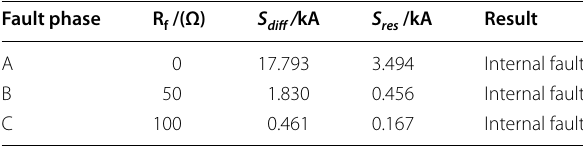
N when single-phase 3 4 3